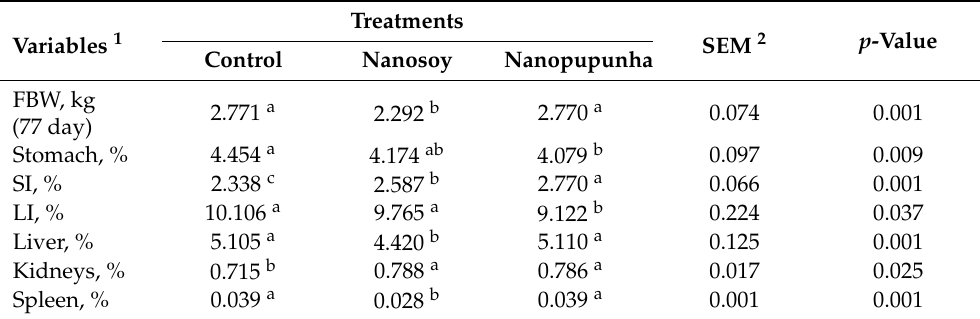
Table 3. Means of the relative weights of digestive tract organs and appendages of growing rabbits fed different sources of nanofibers and those fed a control diet.